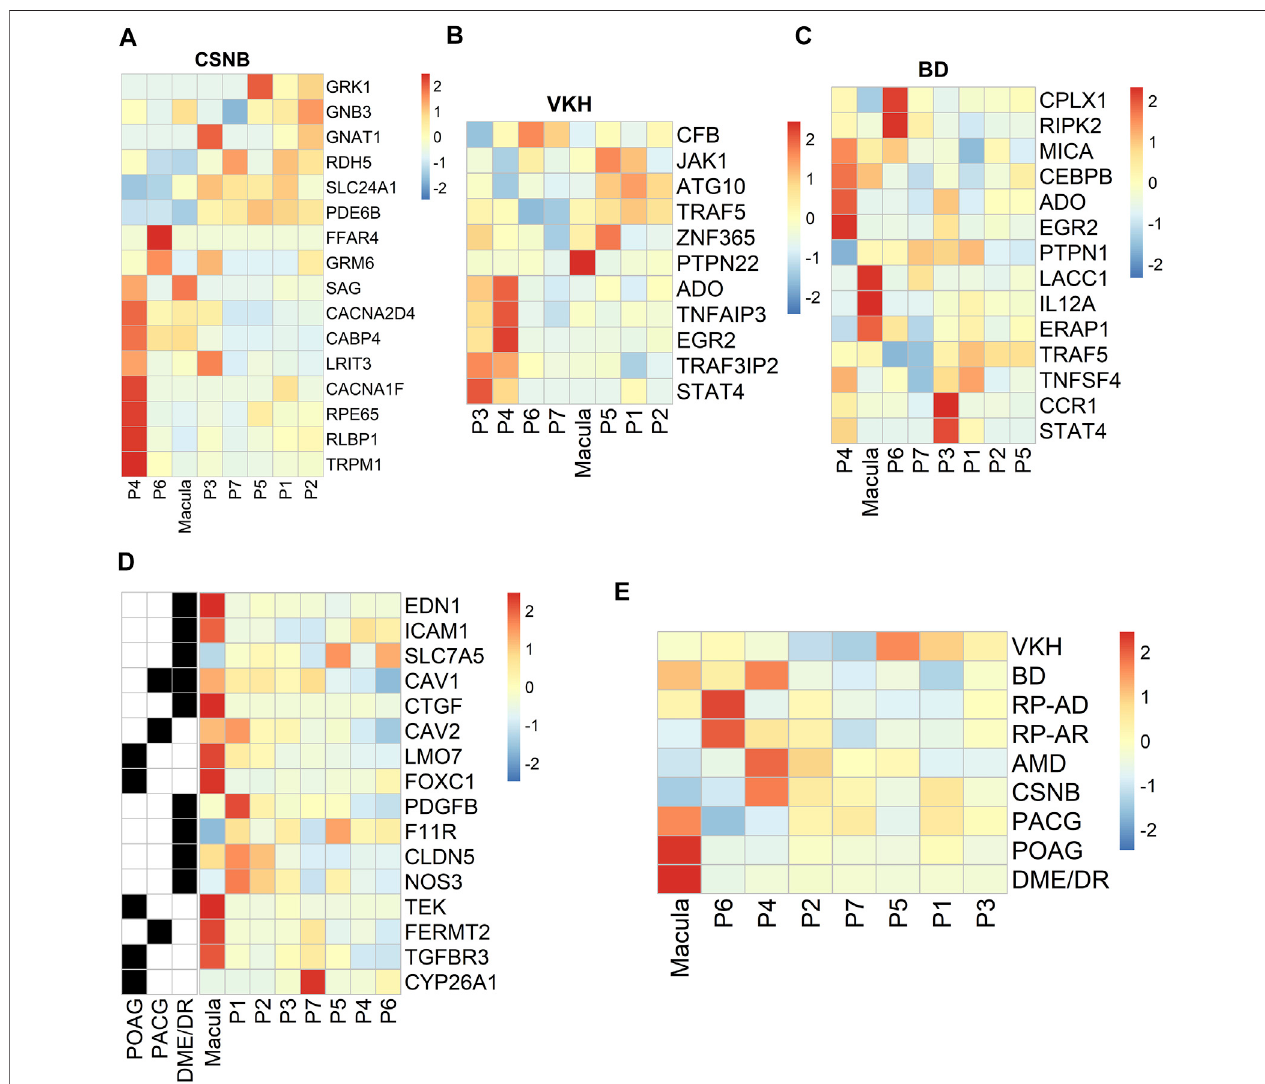
FIGURE 6 | Pro fi ling of speci fi c expression patterns of human retinal disease-associated genes. Aggregated expression of disease-associated genes in macular and peripheral cell types. CSNB, congenital stationary night blindness; BD, Behcet disease; VKH, Vogt-Koyanagi-Harada syndrome. Colorbar: red represents highly expressed and blue represents lowly expressed, scale method is Z-score normalization (A). CSNB (B). VKH (C). BD (D). Expression patterns of speci fi cretinal disease- associatedgenes(rows)byHRPEinthemaculaandperiphery(columns) (E). Knownorcandidategenesformultipleoculardiseases.Oculardiseasesareshownin rows, columns are cell clusters identi fi